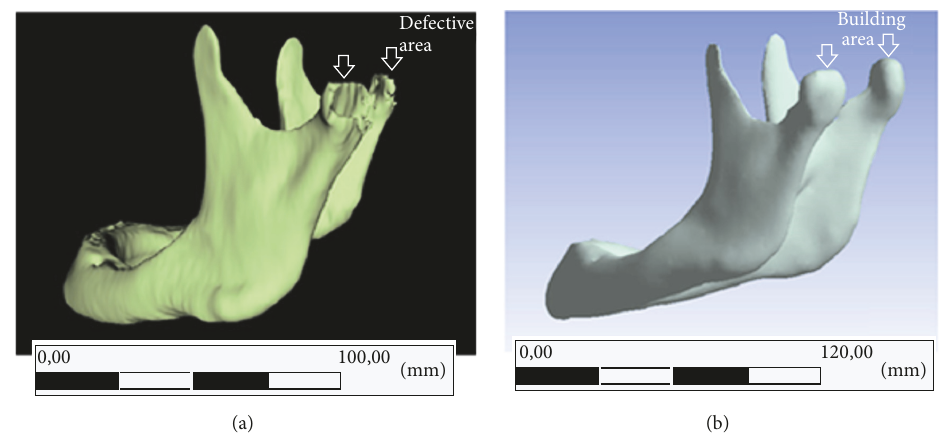
Figure 1: The patient’s jaw with condylar defect (a) and subsequently reconstructed (b).